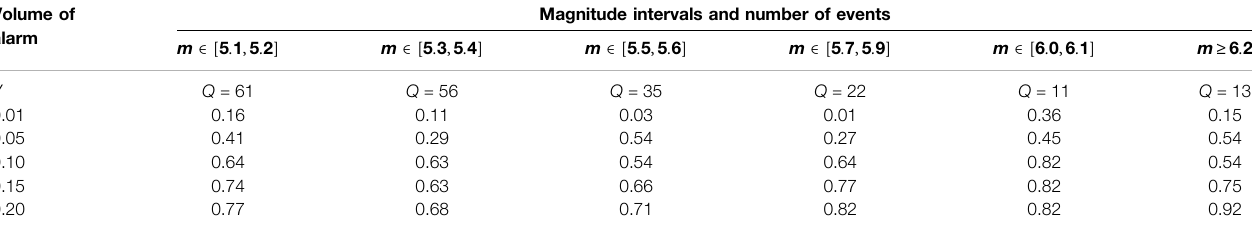
Magnitude intervals and number of events